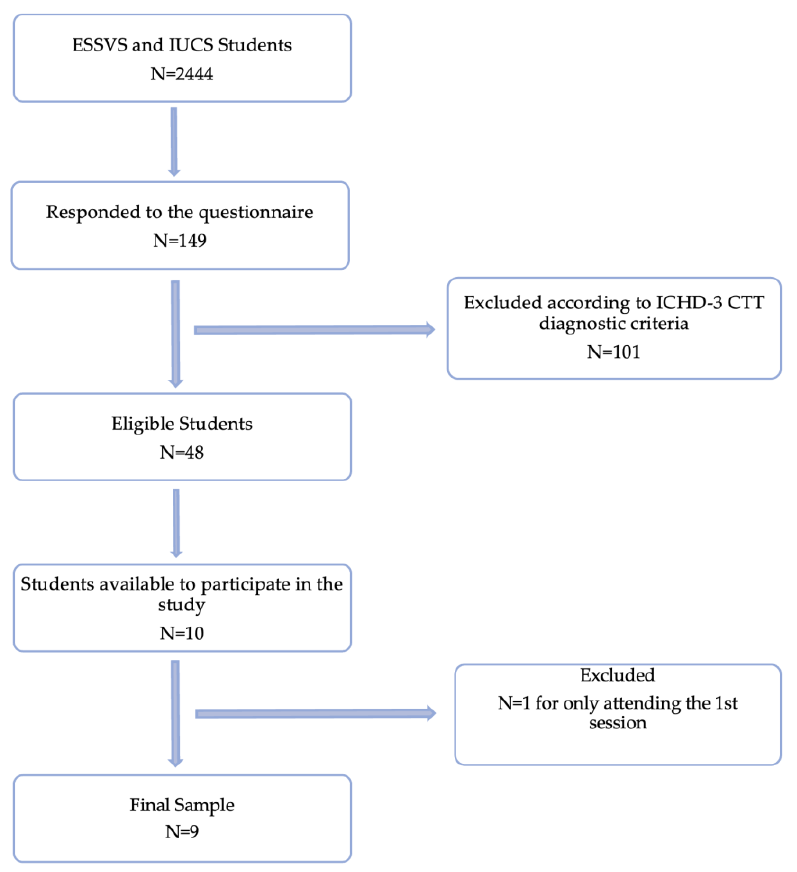
Figure 1. Flowchart of sample selection.